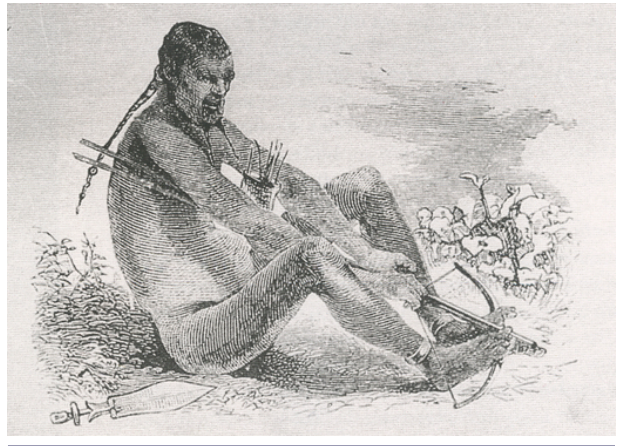
Fig. 4 . Fang crossbowman. Hand-carved engraving by Paul Belloni du Chaillu, 1863 (reproduced from open access archives of the French National Library-